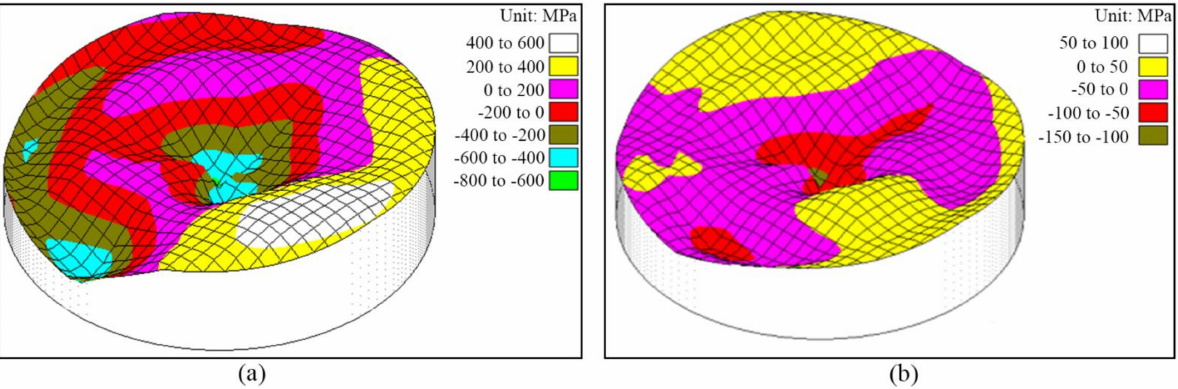
Figure 10. Three-dimensional stress diagram of the composite film: ( a ) before optimization, ( b ) after